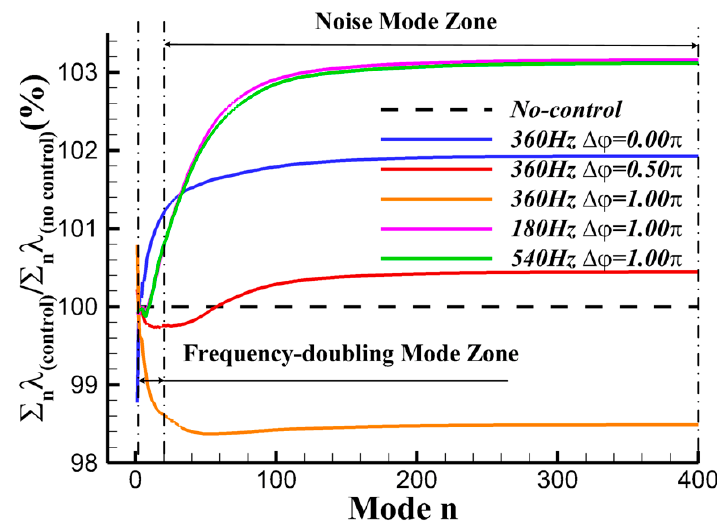
Figure 21. Cumulative energy ratio of the top n modes in several typical control states.